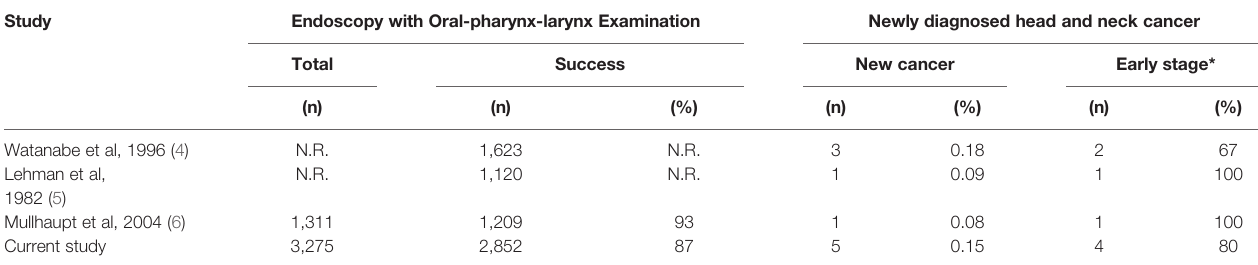
TABLE 2 | Newly diagnosed head and neck cancers detected with regular UGI